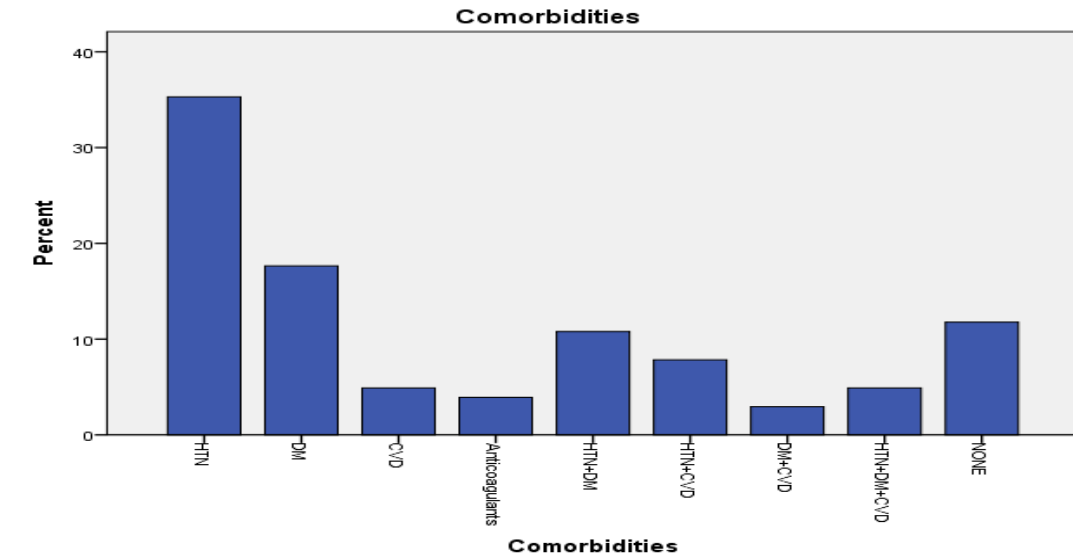
Figure 1: Frequency distribution of comorbidities in patient population